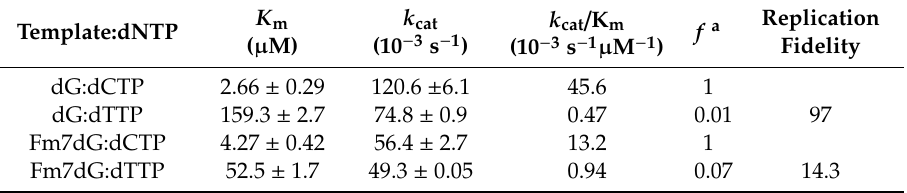
Table 1. Kinetic parameters for nucleotide incorporation opposite Fm7dG and dG by polymerase η (pol η ).